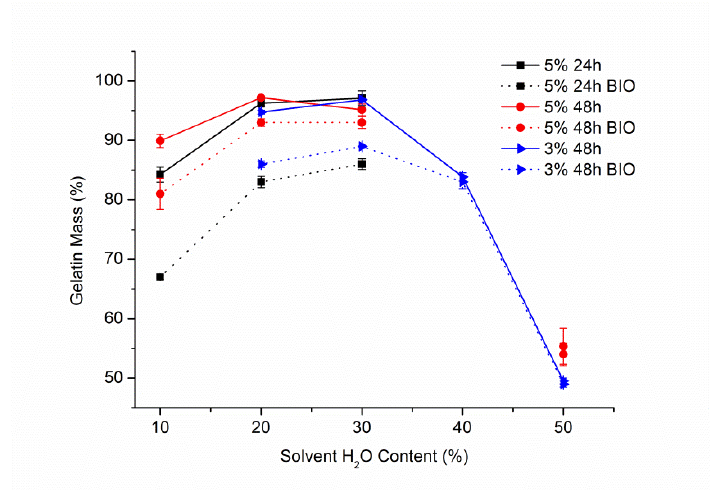
Figure 2. Gelatin content of the samples after crosslinking with genipin solutions and after biodegradation (BIO) test vs. water content in the solvent.